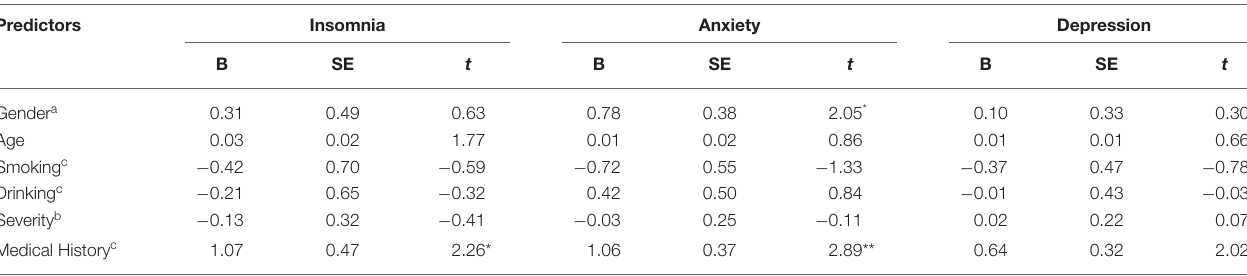
TABLE 4 | The prediction for symptom changes of insomnia, anxiety, and depression. Predictors Insomnia